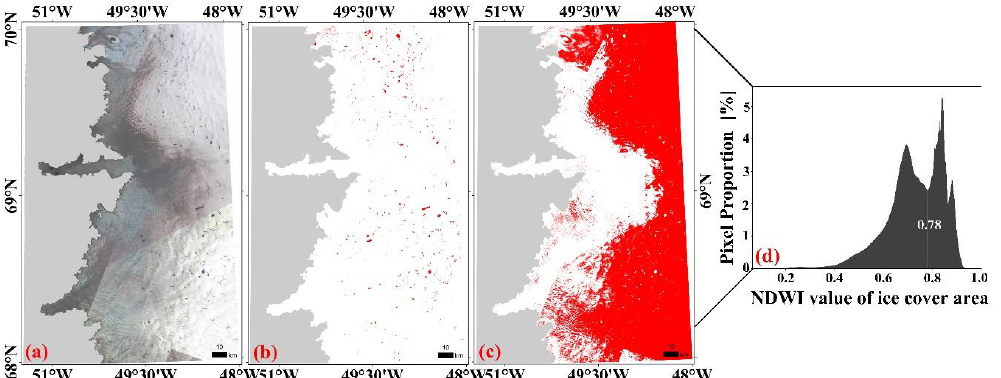
Figure 14. Comparison of water identification between CNN and Otsu. ( a ) Landsat 8 30-meter true-color image from 2018; ( b , c ) water identification results using CNN and Otsu, respectively. Red stands for identified water and gray stands for non-ice-sheet area. ( d ) Histogram of NDWI from 2018 in the ice sheet area.